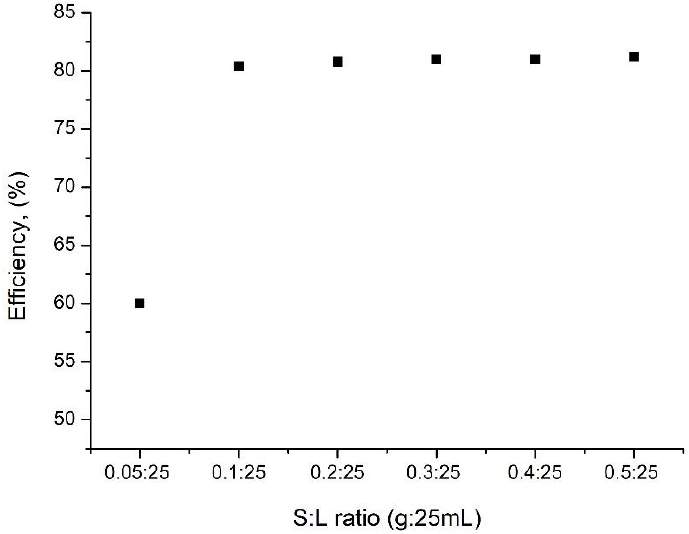
Figure 5. Effect of the dose of adsorbent on vanadium ions adsorption on the SiO 2 Fe x O y material. It is observed that as the S:L ratio increases, the efficiency of the vanadium adsorption process onto the SiO 2 Fe x O y material increases. Starting with the ratio S:L = 0.1 g of adsorbent material:25 mL solution, the efficiency increases, but not significantly (~80%), which determines that all subsequent studies will be carried out at this